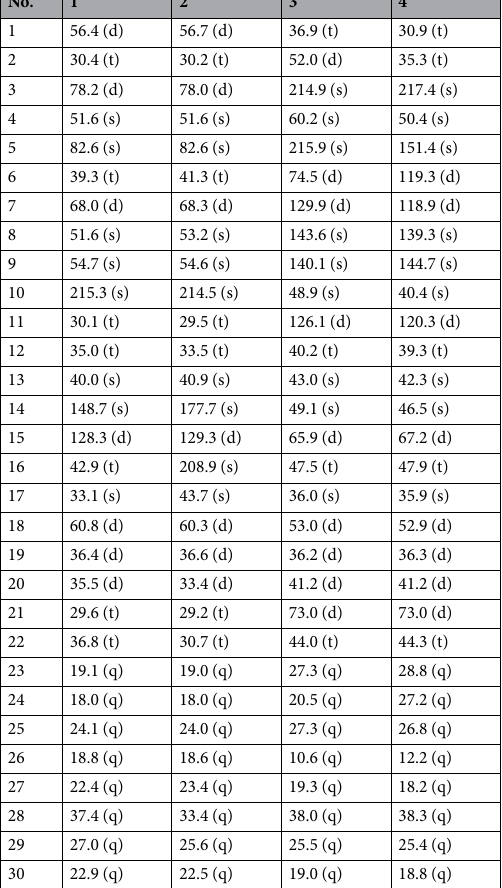
Table 3. 13 C NMR (150 MHz) data of compounds 1 – 4 in CD 3 OD.